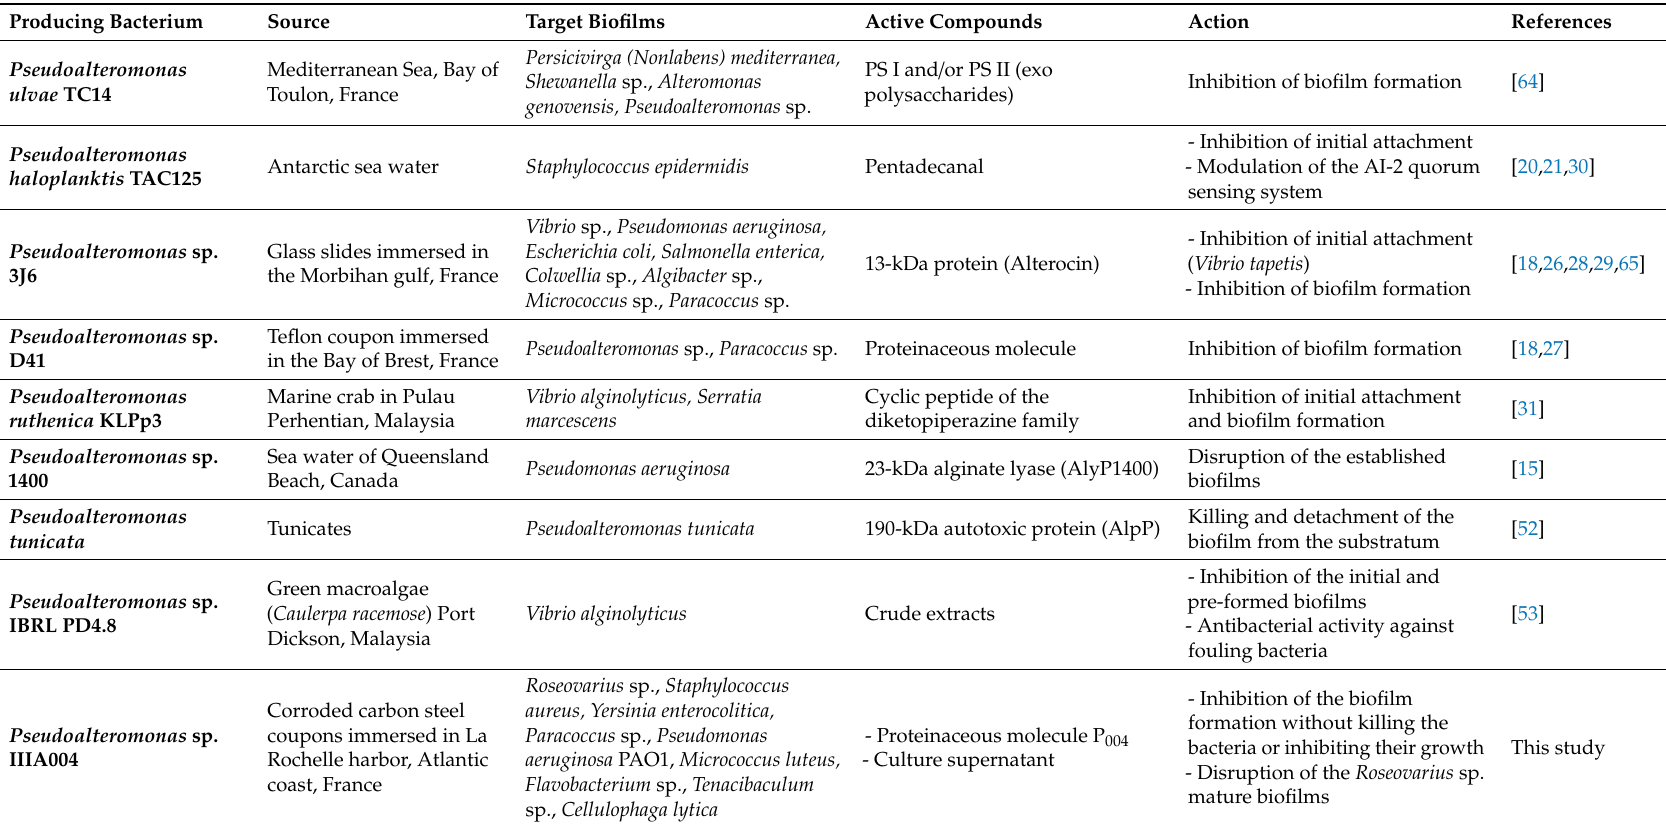
Table 3. Anti-biofilm compounds produced by Pseudoalteromonas sp.